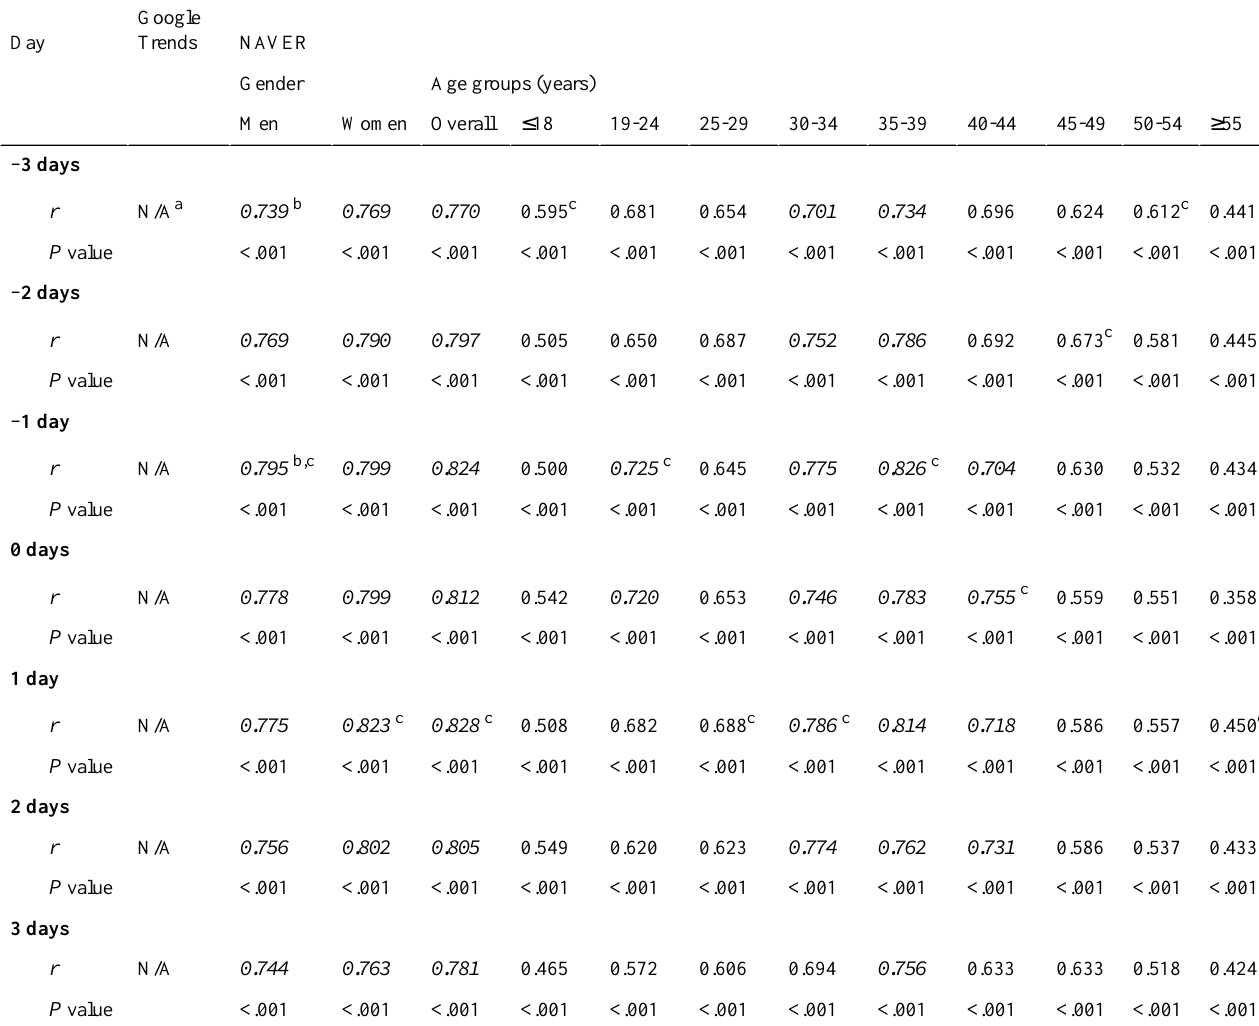
Table 2. Time-lag correlation coefficients between new COVID-19 cases, Google Trends, and NAVER relative search volumes related to the coronavirus test in South